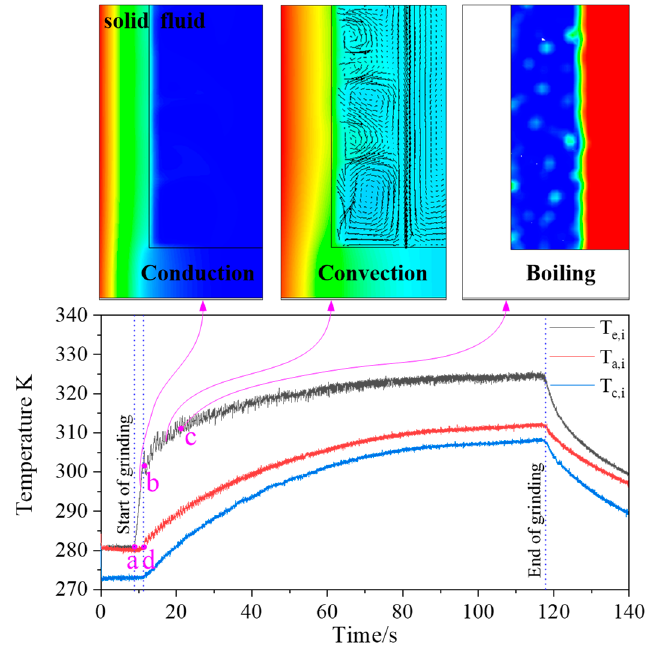
Figure 11. Startup process of RHP-GW.